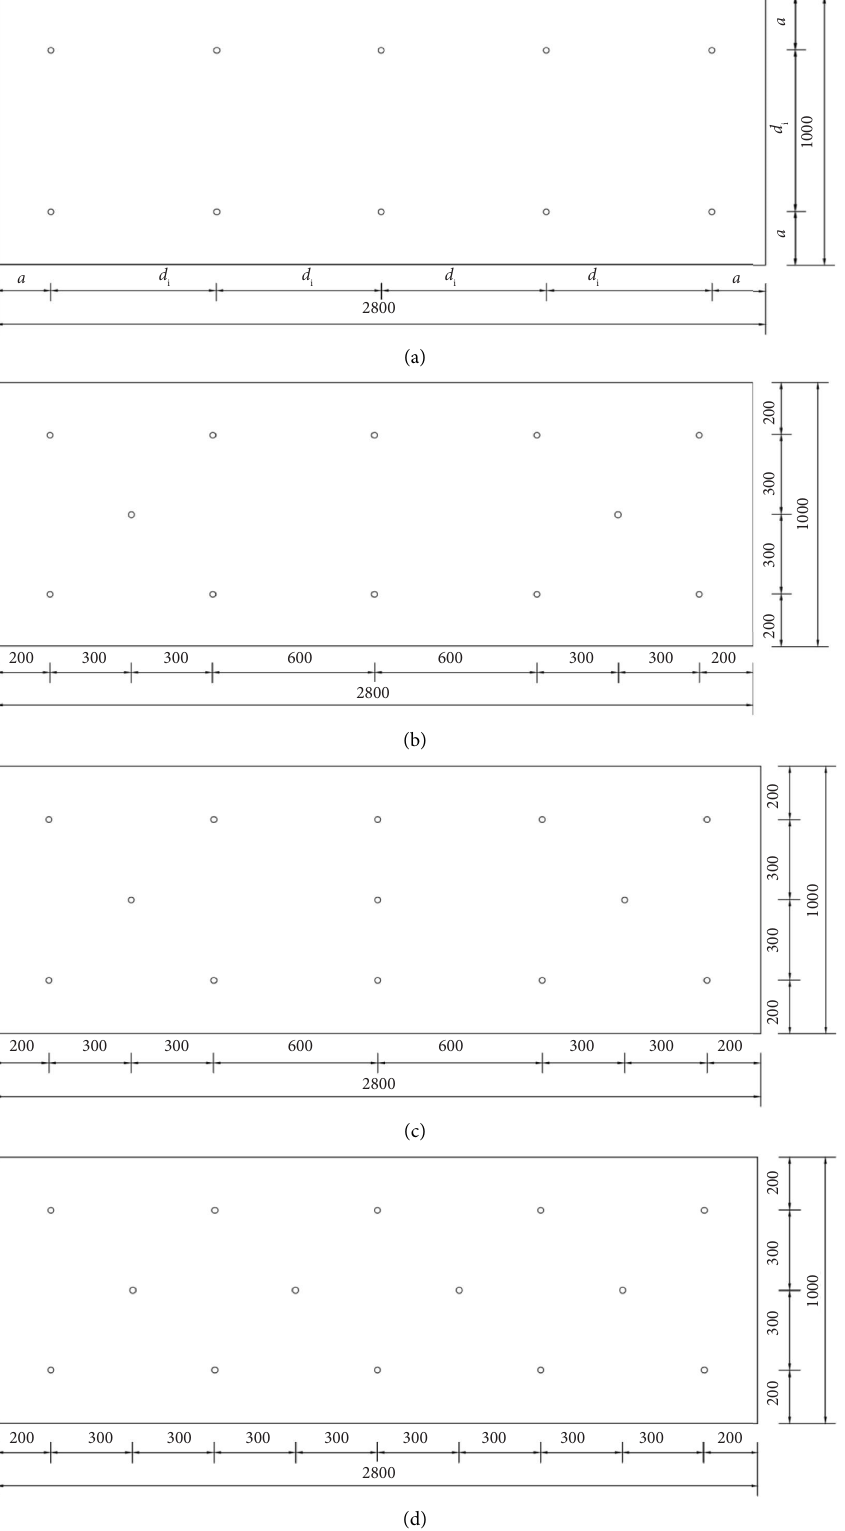
Figure 16: Te arrangement of shear connectors tried in the FE model for specimen G24-I (units: mm). (a) Te distance between shear connectors, (b) arrangement of 12 shear connectors, (c) arrangement of 13 shear connectors, and (d) arrangement of 14 shear